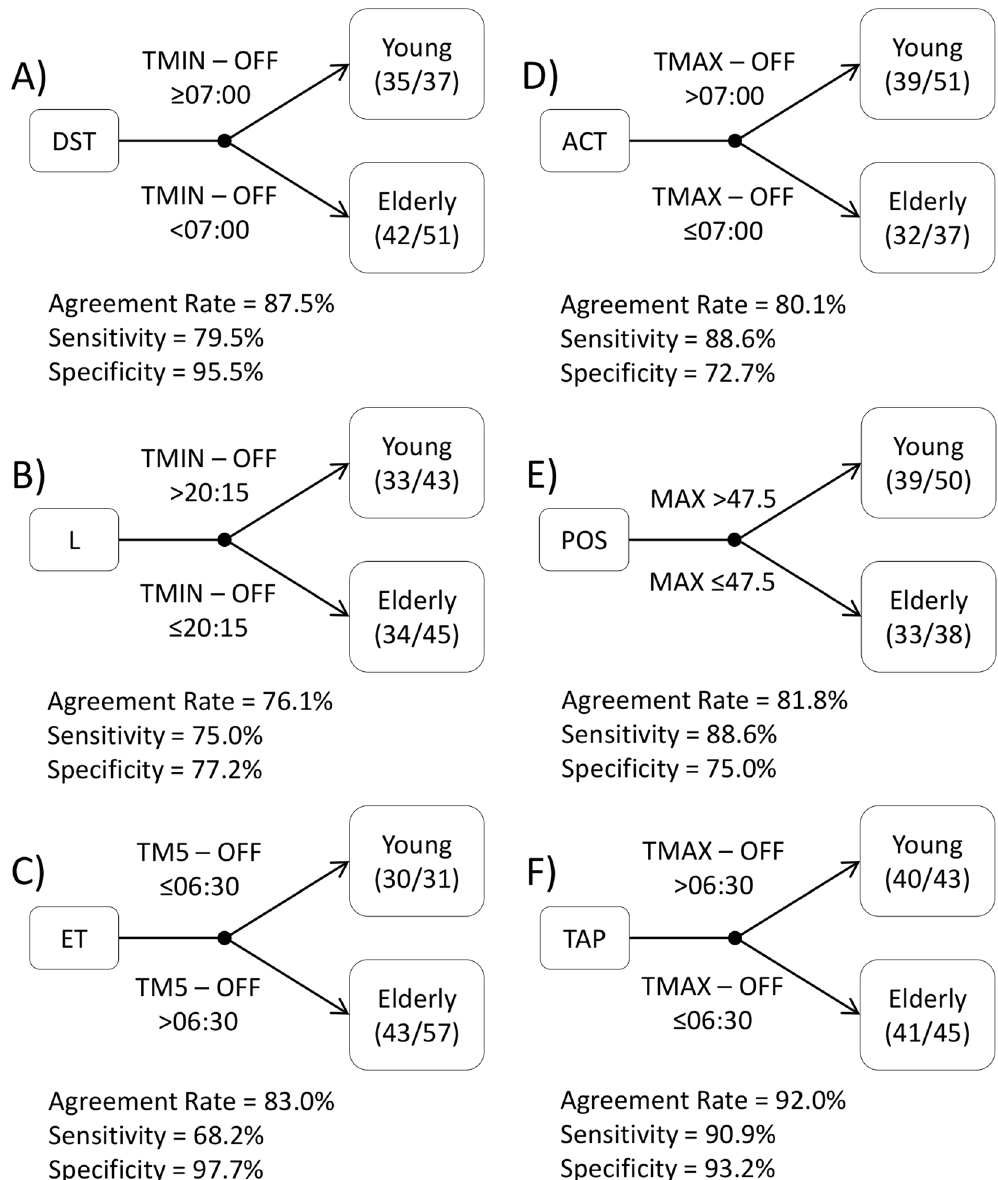
Figure 3. Individual variable decision trees. Decision trees for classifying subjects as young or aged based on distal skin temperature (DST) by TMIN-OFF ( A ), light exposure (L) by TMIN-OFF ( B ), environmental temperature (ET) by TM5-OFF ( C ), activity (ACT) by TMAX-OFF ( D ), body position (POS) by the M10 value ( E ) and the integrated variable TAP by TMAX-OFF ( F ). Agreement rate, sensitivity (test’s ability to correctly detect young subjects) and specificity (test’s ability to correctly detect elderly subjects) are indicated below each variable’s name, classification rules appear immediately to the right (upper part for young, and bottom part for aged participants), and end nodes are included on the right, indicating the correct classifications with respect to the total number of individuals in each particular